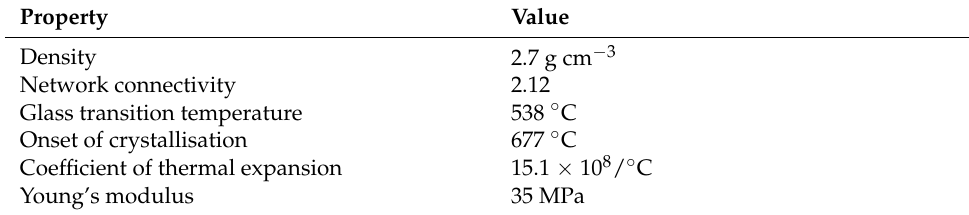
Table 4. Properties of Bioglass ®